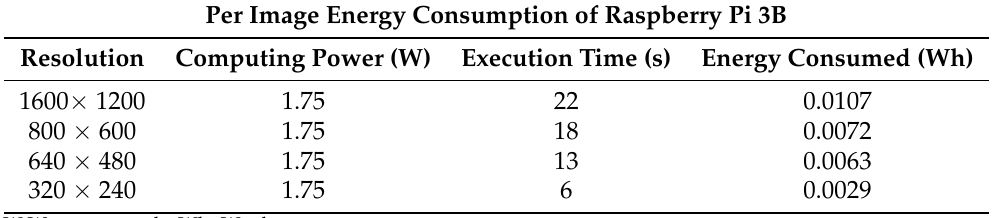
Table 4. Energy consumed by Raspberry Pi 3B for processing an original image to create an opti- mized